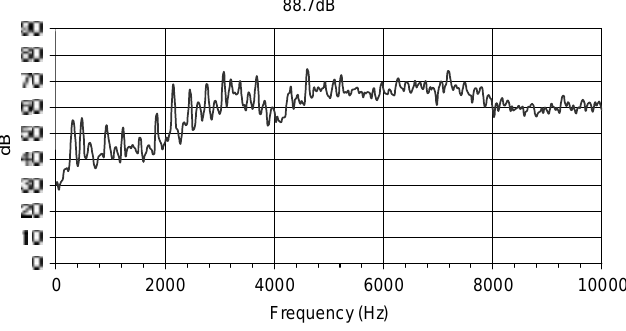
Fig. 10. Predicted noise spectrum using FE simulation Results.